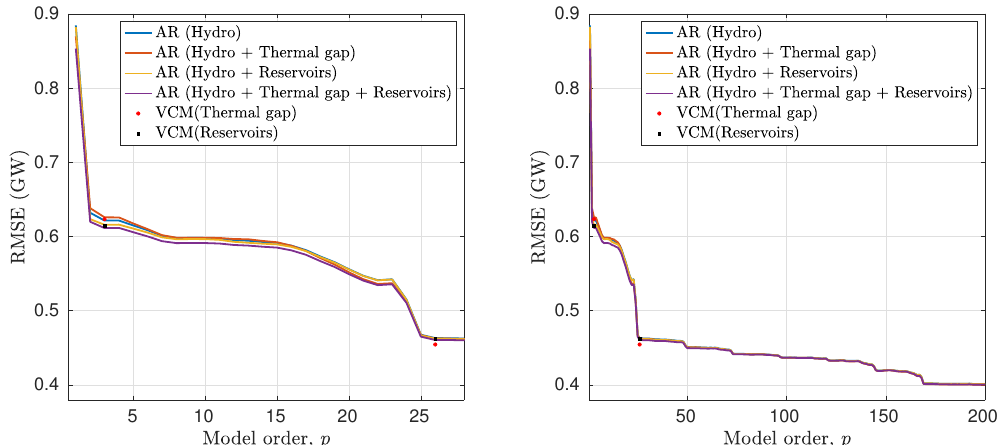
Figure 1. Root Mean Squared Error (RMSE) of the different point-forecasting models, as a function of the autoregression order, p